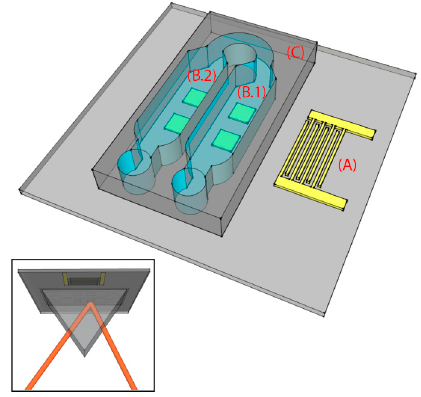
Figure 1. Schematic of the surface acoustic wave (SAW)-enhanced surface plasmon resonance (SPR) chip. The chip is characterized by three main parts, patterned on a lithium niobate (LN) substrate: an interdigital transducer (IDT) for SAW excitation (A), four SPR sensing areas (B), and a polydimethylsiloxane (PDMS) microchannel with two microchambers (C). The microchambers are designed so that the SAWs are present only in B.1, while they are totally damped before reaching B.2. The inset shows the chip (seen from below) in the Kretschmann configuration.